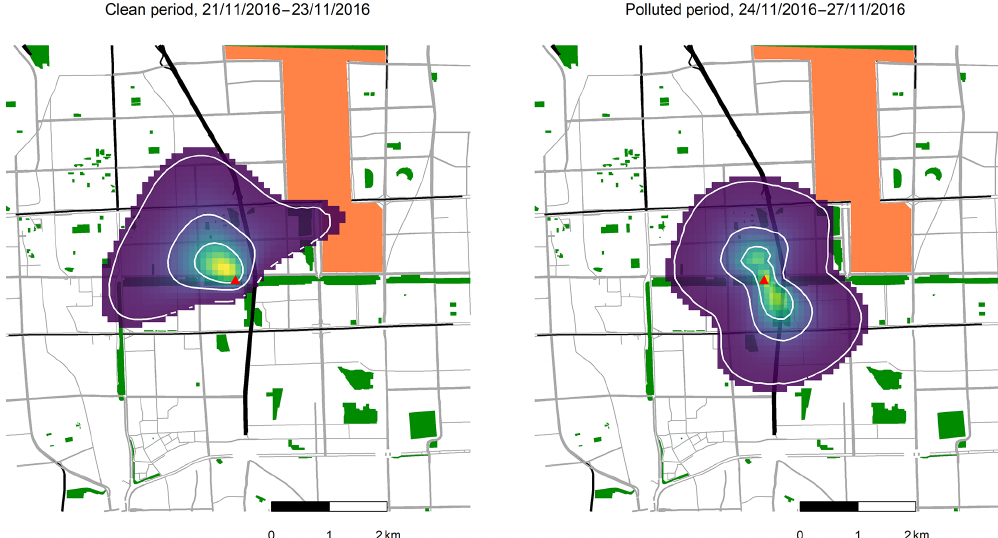
Figure 7. Average footprints for the “clean” period, 21 November 2016–23 November 2016 (left), and the “polluted” period, 24 Novem- ber 2016–27 November 2016 (right). Map was built using data from © OpenStreetMap contributors 2019. Distributed under a Creative Commons BY-SA